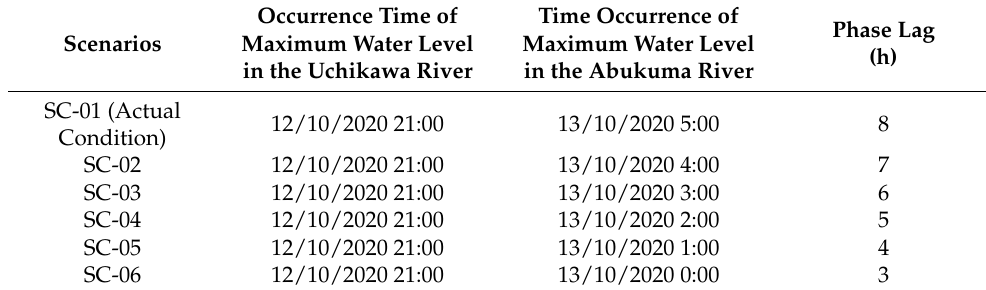
Table 1. Summary of model